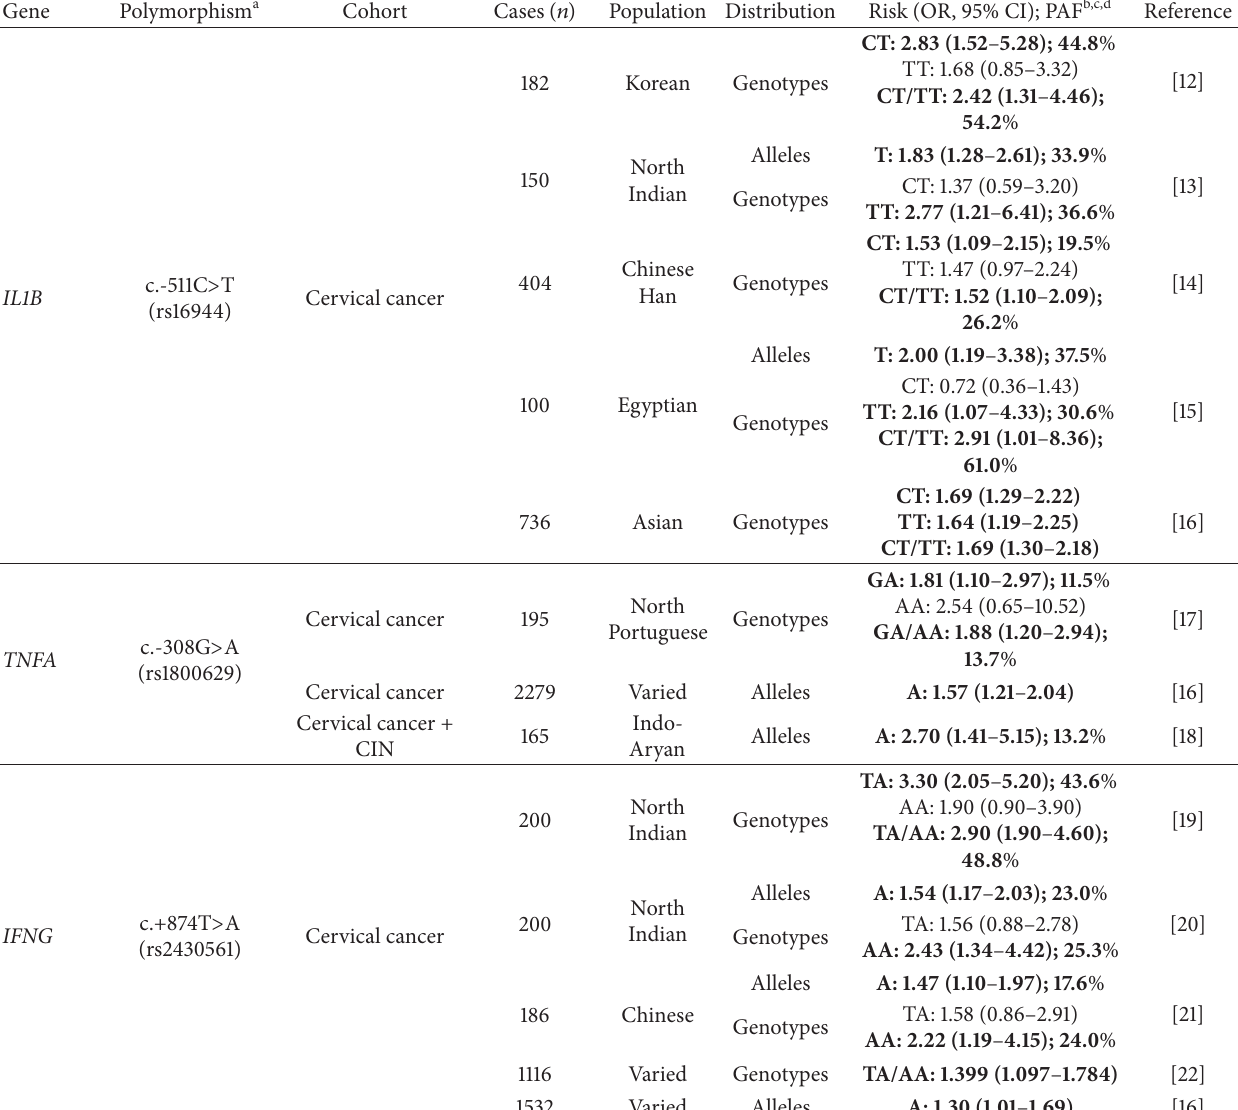
Table 1: Overview of polymorphisms in genes encoding proinflammatory cytokines and association with cervical neoplasia risk.